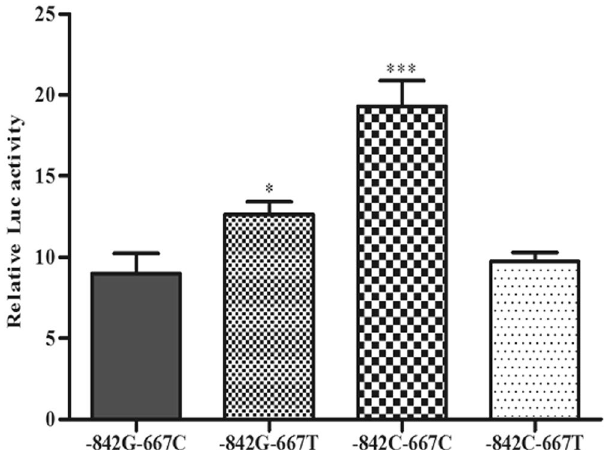
Figure 2. Luciferase activity of reporter gene expressions driven by the four haplotypes of PIN1. * P < 0.05, compared to -842G-667C; *** P < 0.001, compared to